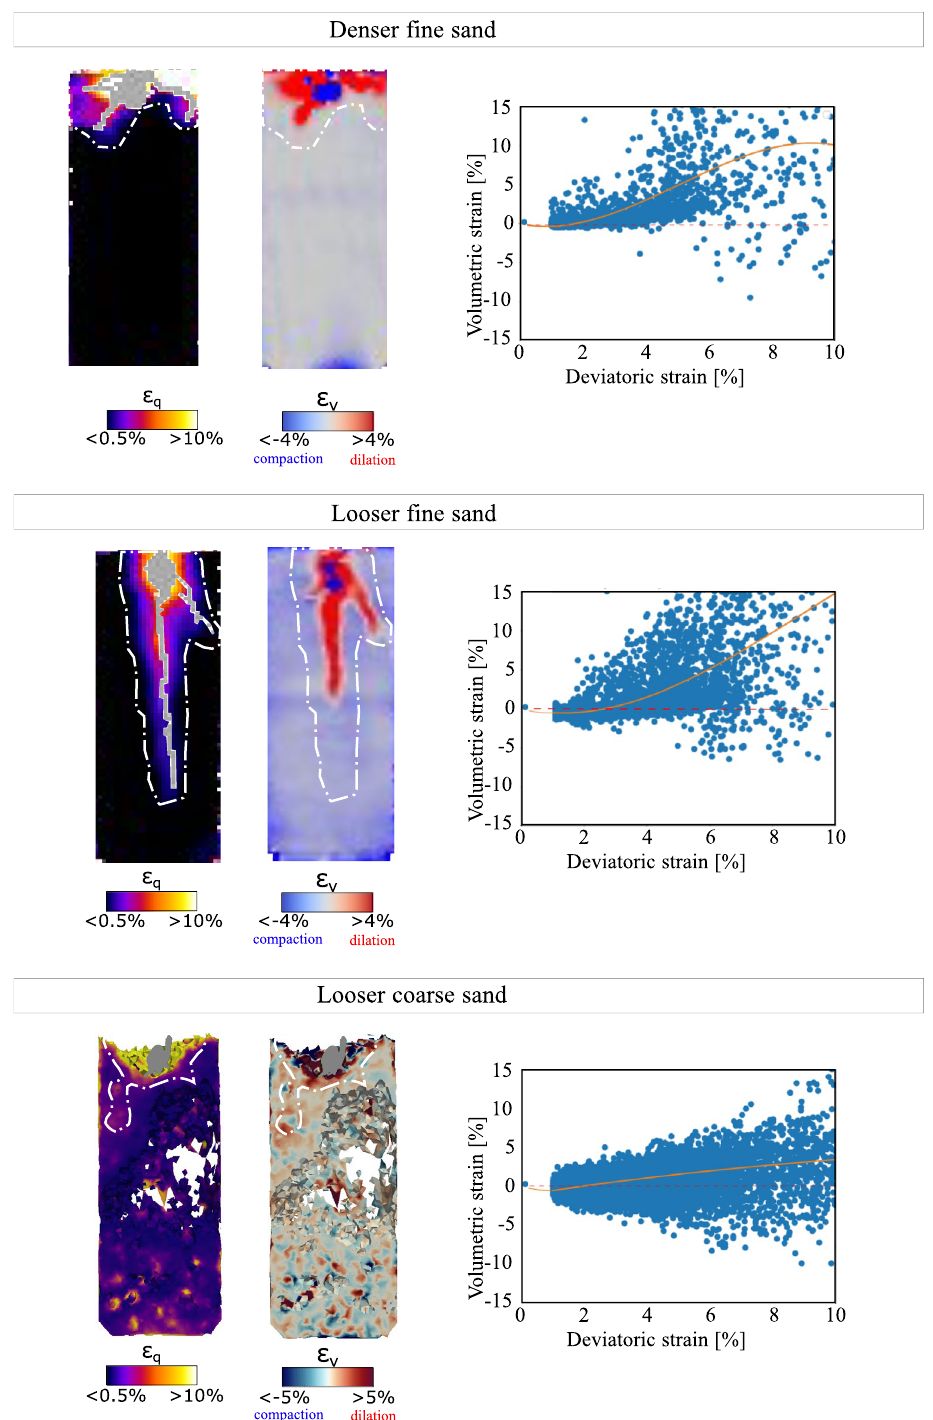
Figure 7. Identification of root-sheared soil with ε q > 1% in both strain fields – deviatoric and volumetric (the white dashed line defines the boundaries “engaged volume” used to plot ε q vs. ε v ). The plots on the right hand- side show volumetric strain ε v versus deviatoric strain ε q . From top to bottom: the effect of maize root growth on fine denser sand, fine looser sand, and coarse looser